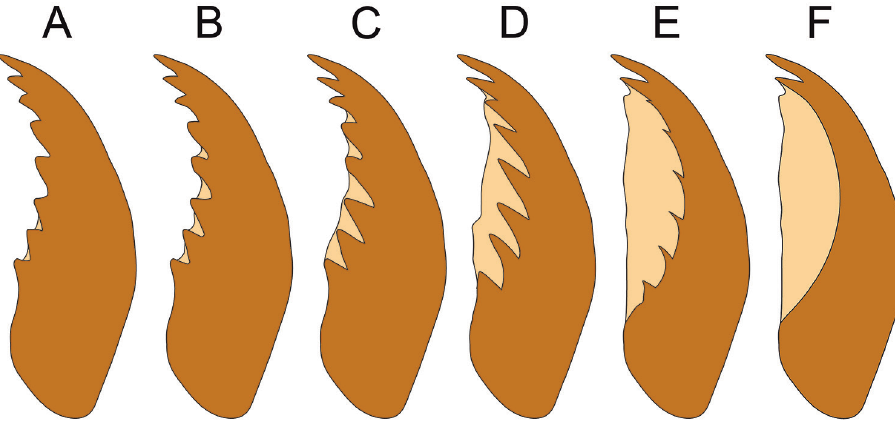
Figure 7. Proposed evolution of jaws in Namanereidinae. A Jaws with fully dentate cutting edge, layer al- most inconspicuous in basal teeth B Layer increases their extension among basal teeth and reaches medial ones C Layer covers completely basal and medial teeth, and reaches subterminal ones D Teeth recede and become narrow, layer covers subterminal teeth excepting the last two E Just remnants of teeth are visible if any, layer increases its extension F Teeth fully replaced by the layer. Stages B and C in most Namalycastis species and Namanereis with serrated cutting edge; stage D as in Namanereis stocki and N. tiriteae ; stage E as in Namanereis socotrensis ; stage F as in Namanereis with bifid jaws and Namalycastis occulta